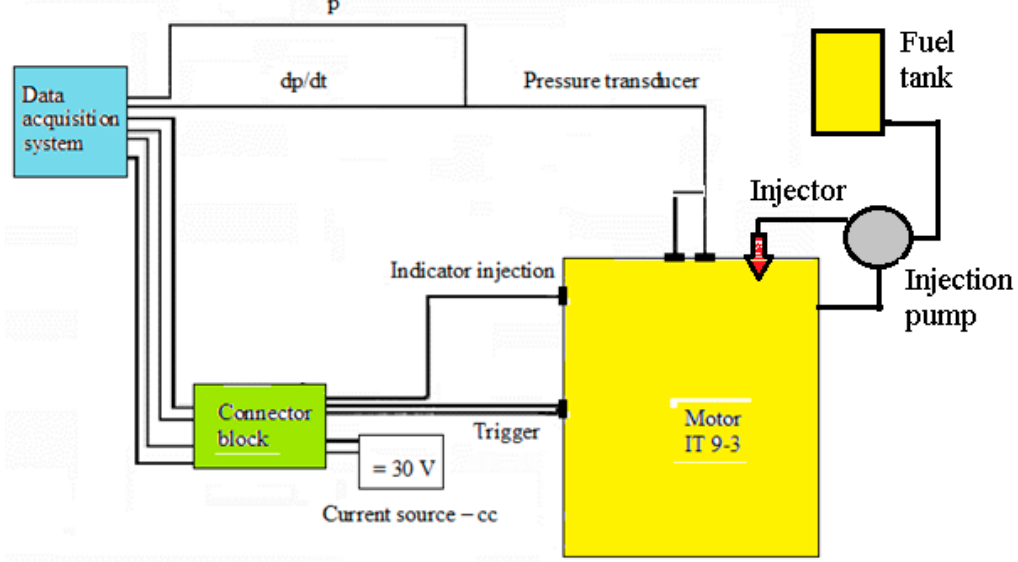
Figure 1. Internal combustion engine test